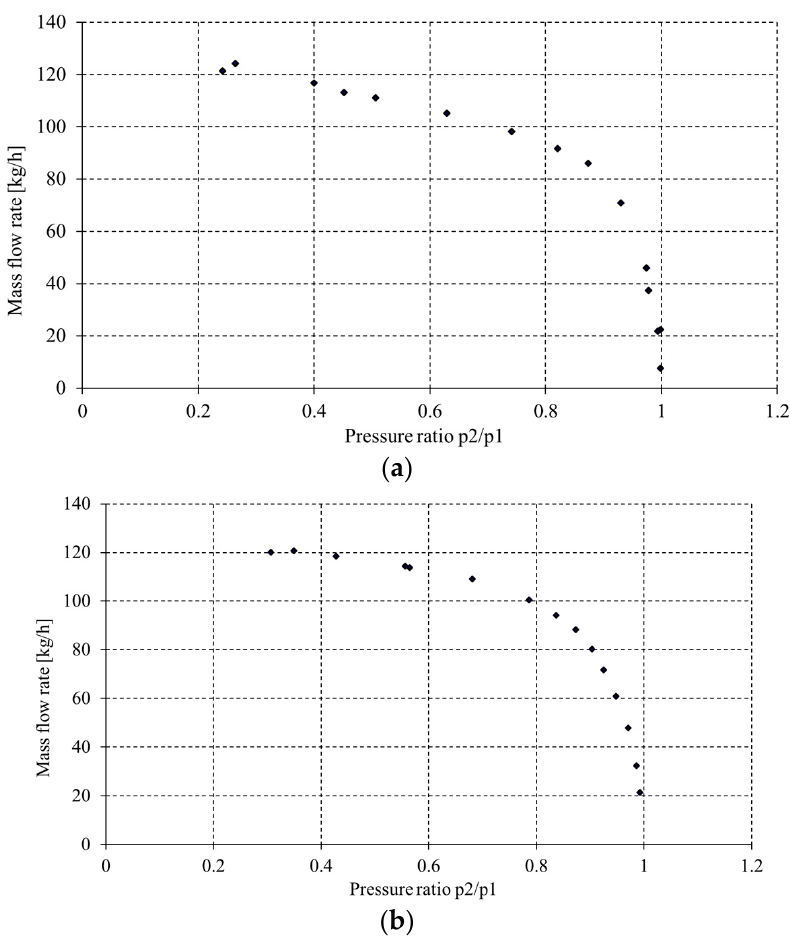
Figure 10. Dependence of the mass flow rate on the pressure ratio for the OBREiUP G1/2 manifold No. 611.012.964, working position: ( a ) currentless, ( b ) coil energized.